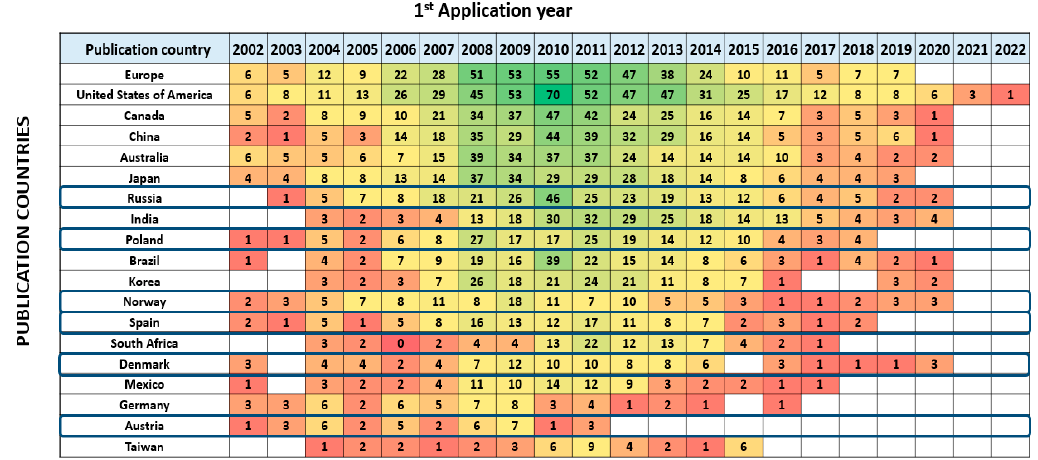
Figure 6. Patent filing trend across Northern and Eastern European countries. The figure uses two colors to represent high and low numbers i.e., the more green represents high number and more red indicates a lower figure of patent filling trend across the countries.